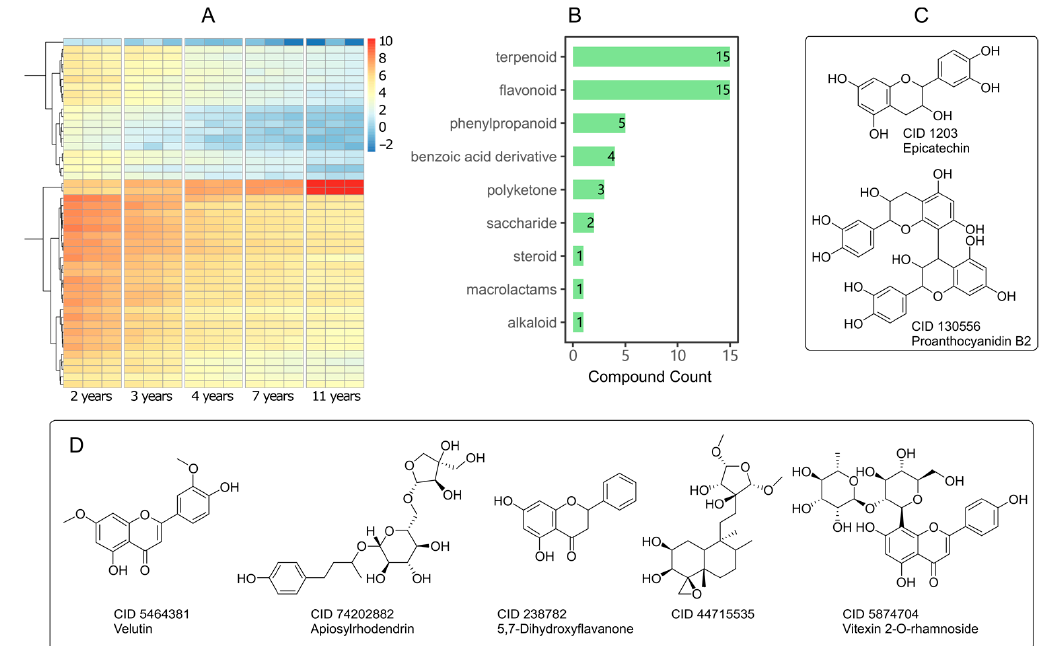
Figure 4. Main components in leaves affected by tree ages. ( A ) Hot spot map of increasing and decreasing components depending on tree age. The color palette represents the content of metabolites. ( B ) Components counts in different structural types. ( C ) Compounds up-regulated annually (FC > 32, p < 0.01). ( D ) Representative compounds down-regulated annually (FC > 32, p < 0.01). See Table S1 for details.